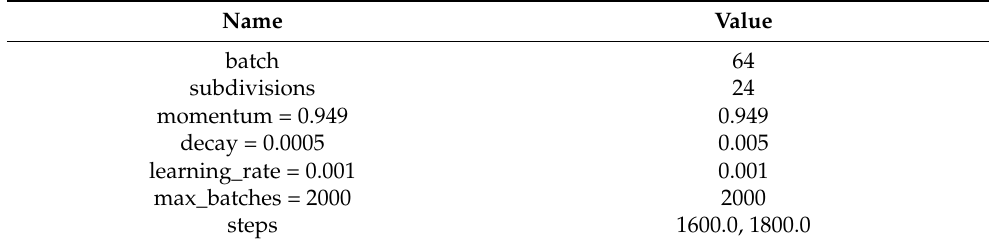
Table 3. Model Hyper parameters set during training.